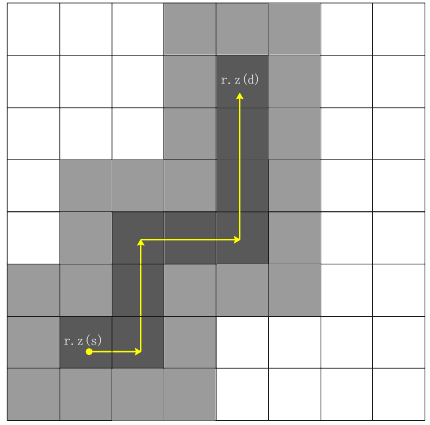
Figure 2. Expanded path of r